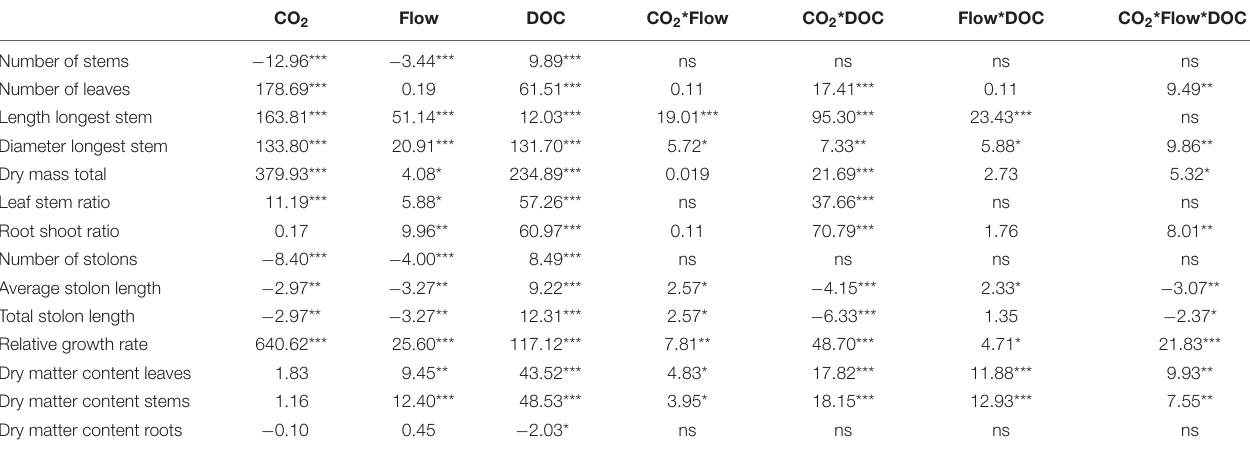
TABLE 1 | F -values of the three-way ANOVA tests and z values of the generalised linear models of growth and morphological parameters ( n =